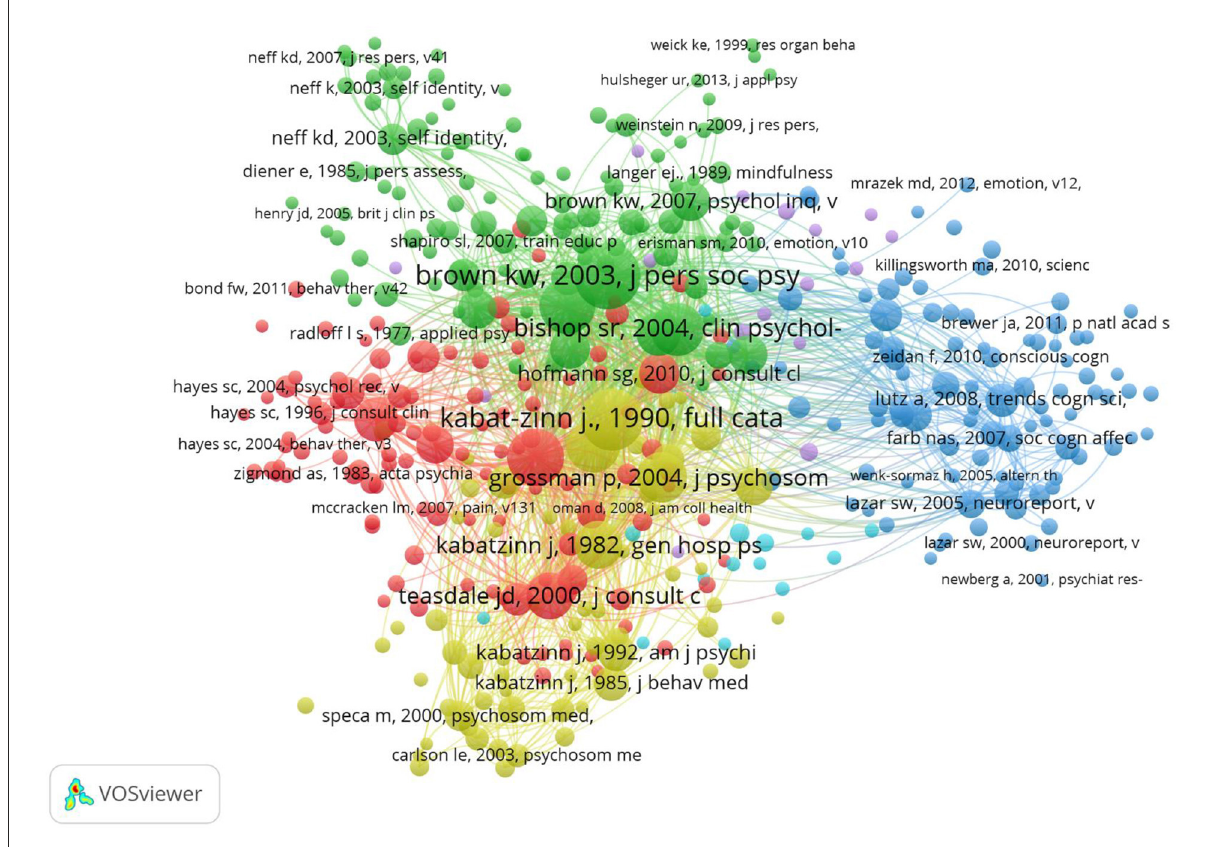
FIGURE1 Network visualization of co-citation